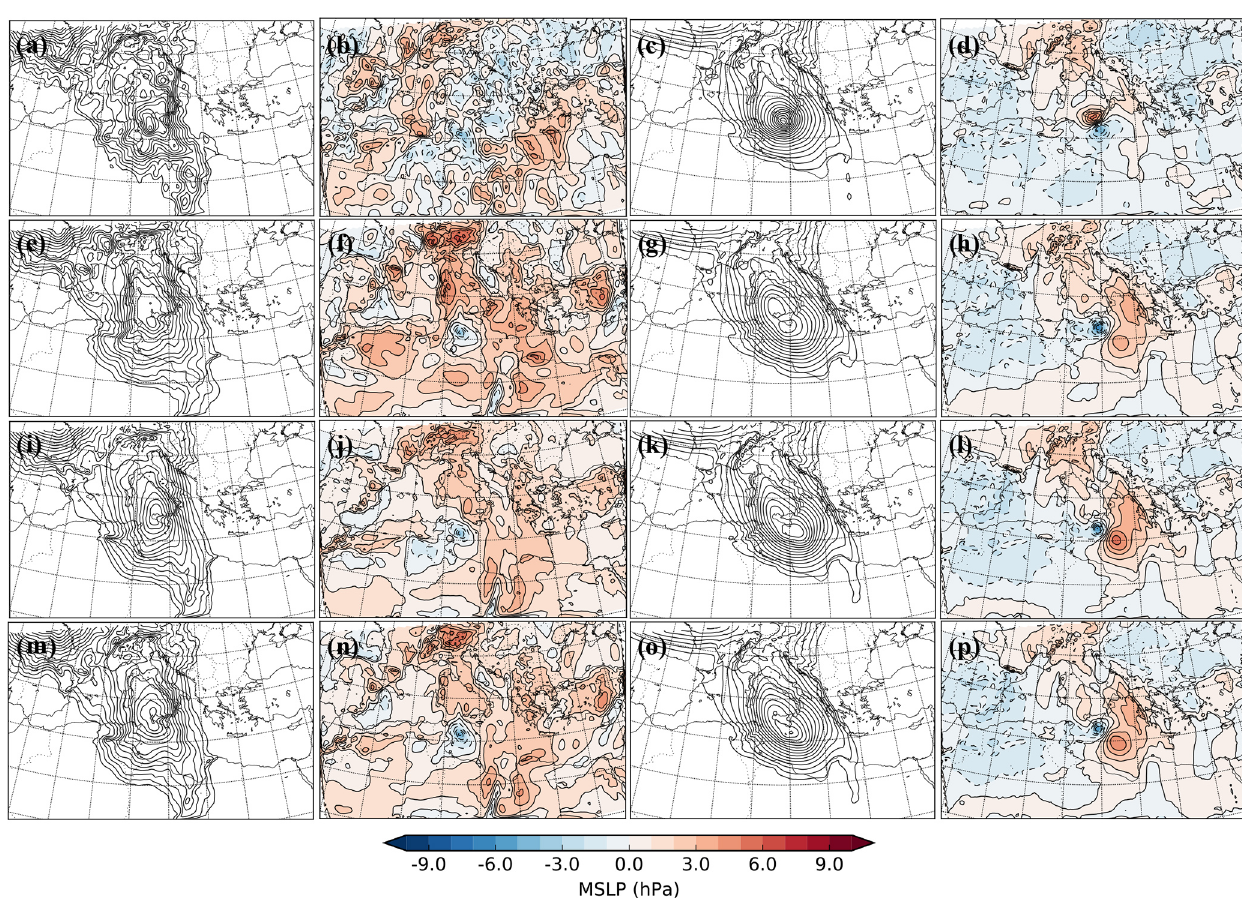
Figure 15. Comparison of the MSLP between the numerical experiments and the ERA5 analysis at 00:00UTC (initial conditions) and 18:00UTC (maximum intensity registered at Malta). NODA, SYN, RSAMV and CNTRL experiments are shown in the first, second, third and fourth row, respectively. MSLP simulated by the different experiments at 00:00 and 18:00UTC are shown in the first and third column, respectively, and the differences between ERA5 and the experiments are shown in the second and fourth columns,